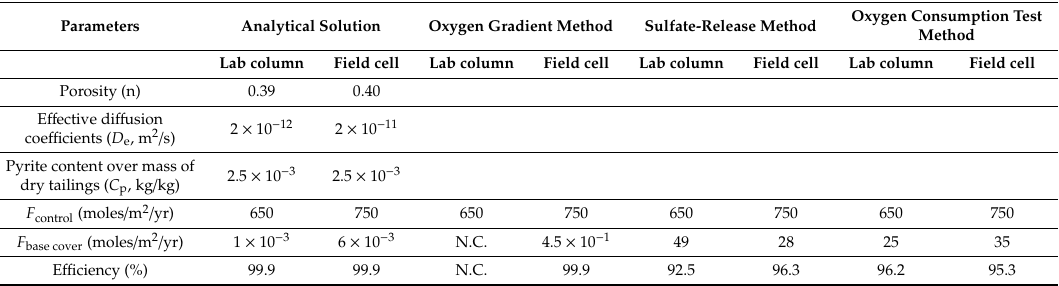
Table 5. E ffi ciency values for CCBE column and field